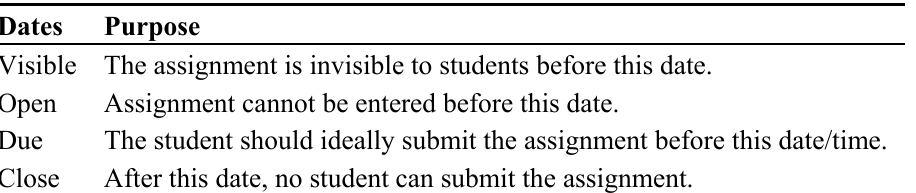
Table 2. Assignment Dates in LiquiZ.